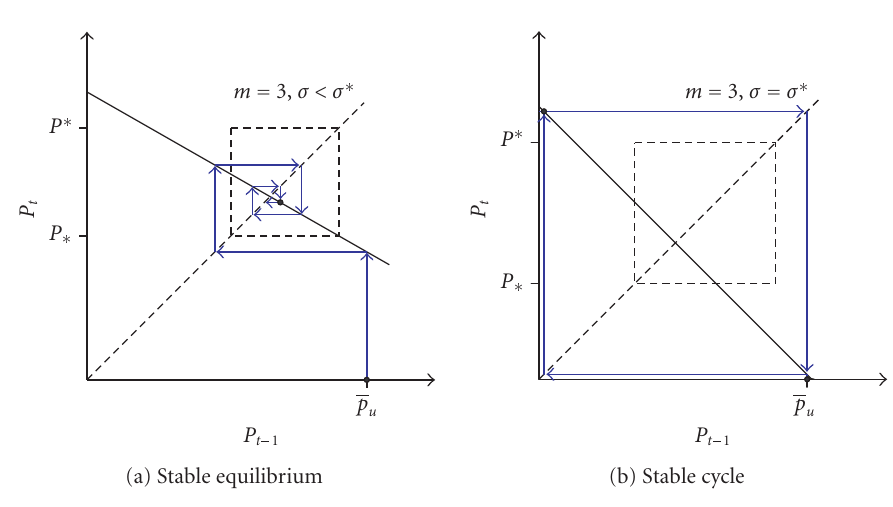
Figure 4.4. Transitionary dynamics: starting with a full